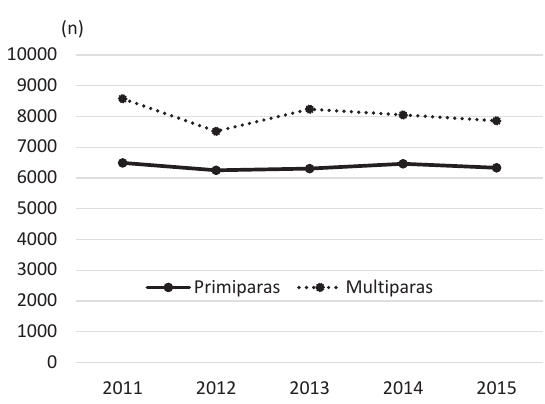
Figure 3. Trends in number of births in Fukushima according to government vital statistics 2